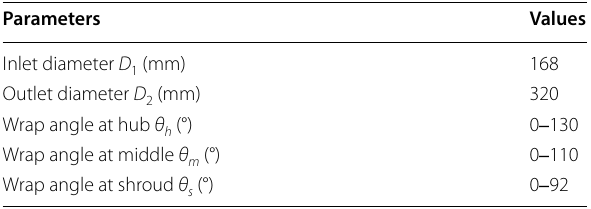
Table 1 Geometrical variables of the runner blade Parameters Values